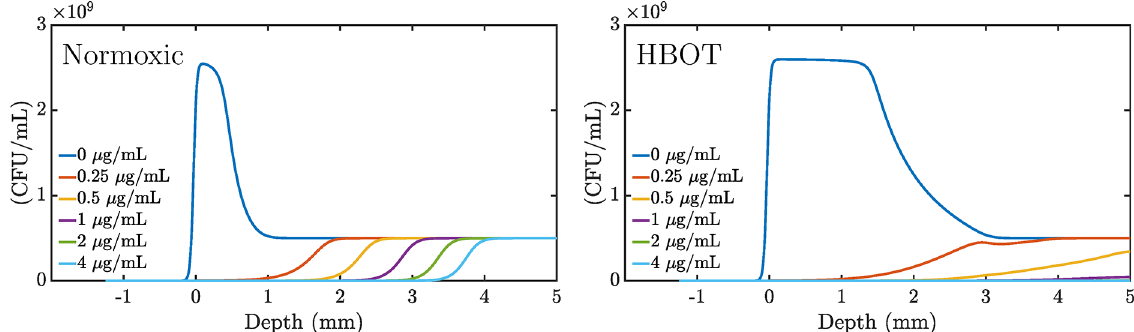
Fig 7. Bacterial killing along the depth dimension of the biofilm. Simulation of a 4 hour treatment scheme with six different doses of ciprofloxacin in a 5 mm biofilm model. The initial concentration ciprofloxacin in the supernatant is indicated in the figure while the equilibrated concentration is 5 times lower. Bacterial density is measured in (CFU/mL). Left: Normoxic treatment. Right: Hyperbaric oxygen